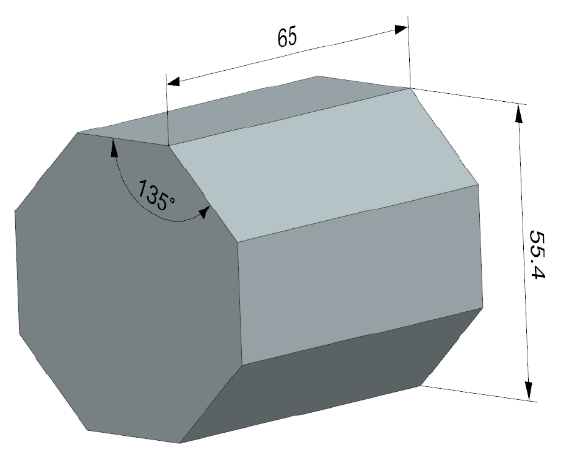
Figure 3. Dimensions of the test sample.